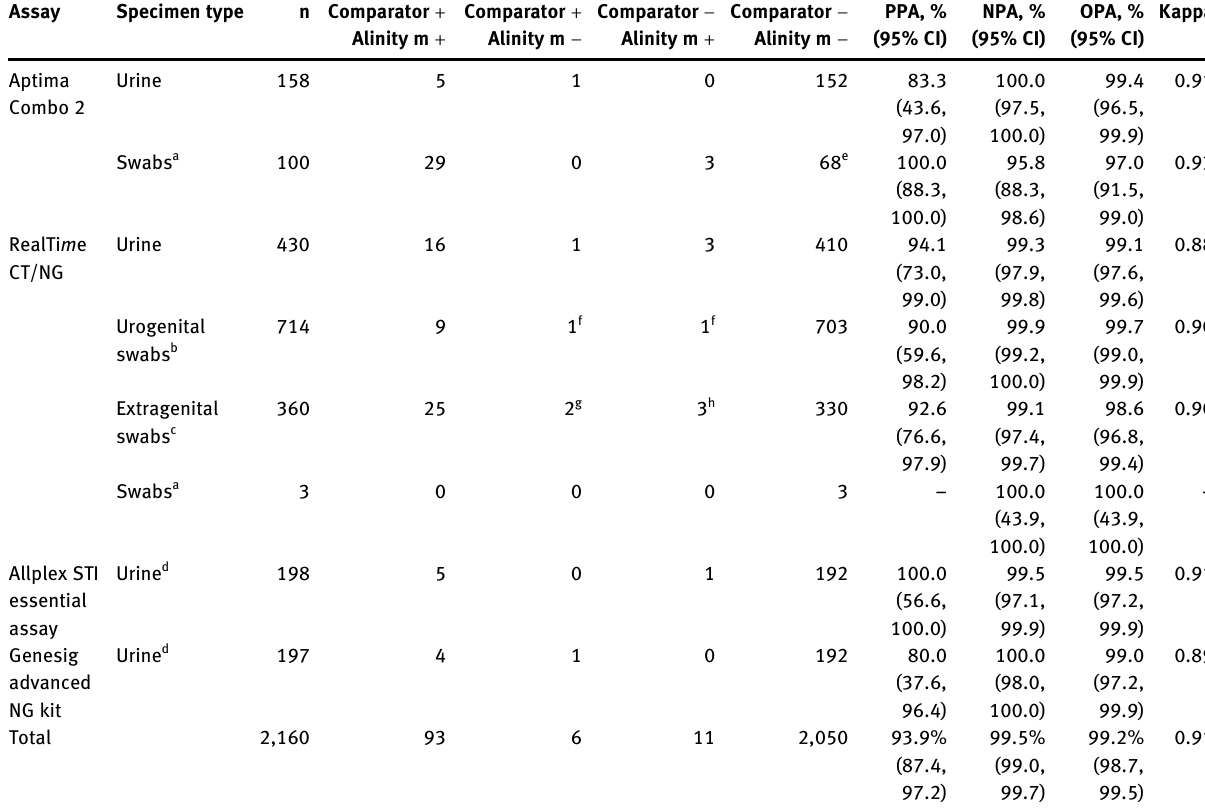
Table  : Performance of the Alinity m STI assay and comparator assays for N. gonorrhoeae. Assay Specimen